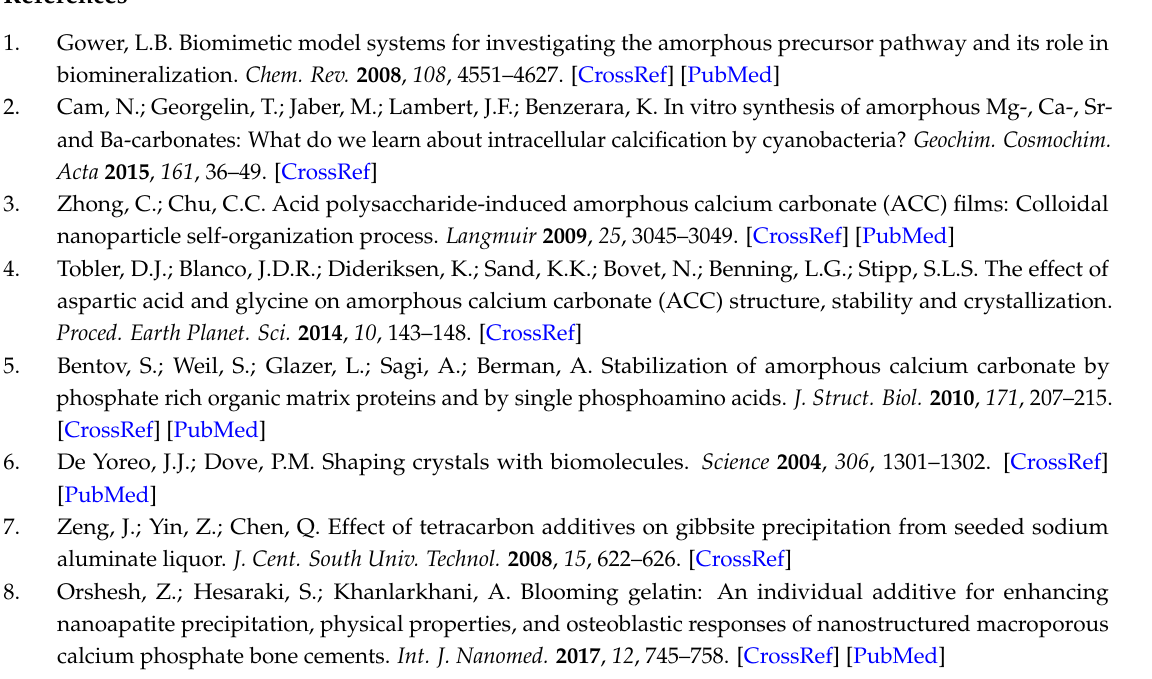
Figure S1: (a) Enthalpy of hydration vs. ionic radii and (b) Standard molar Gibbs energy of hydration of an ion vs. ionic radii. Note the quasilinear relationship between both variables with decreasing ionic radii; Figure S2: FESEM images of vaterite to calcite transition from the same titration run as seen in Figure 5b showing (a) vaterite attached to calcite. The development of growth steps is observed on the calcite surface; and (b) calcite crystals with vaterite